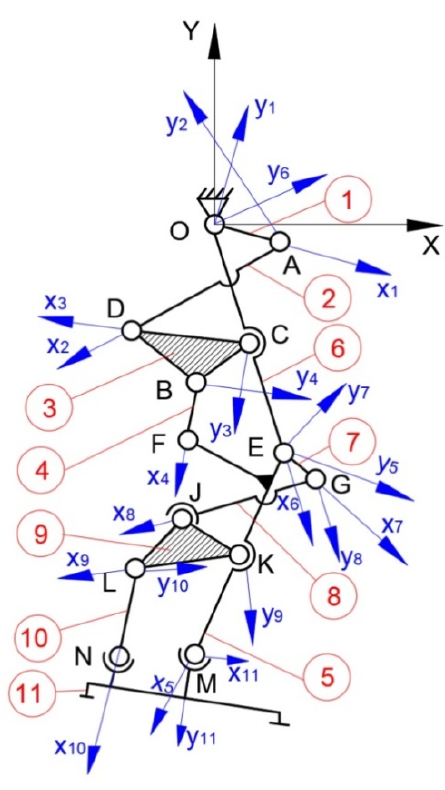
Figure 8. Kinematic scheme of the exoskeleton lower limb.